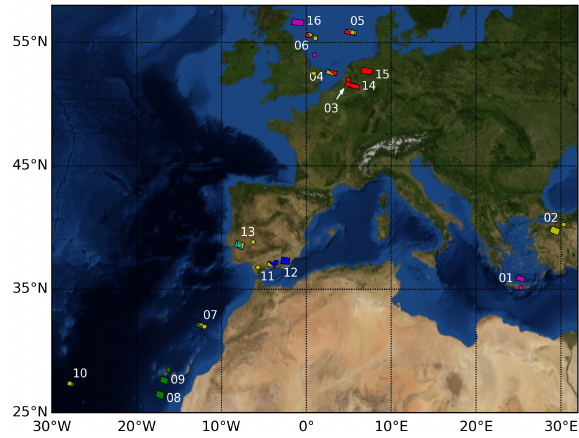
Figure 5. Overview of GOME-2A target pixels (numbered quad- rangles) and corresponding lidar measurements (circles). The li- dar measurements are described in Table 5. Color code for li- dar measurements: FAAM aircraft (magenta), CALIPSO (yel- low), Cabauw (red), Santa Cruz (green), Granada (blue), and Evora (cyan). For some pixels, two lidar measurements are avail- able for evaluation. There are nine GOME-2A target pixels over sea (target pixels 01, 04, 05, 06, 07, 08, 09, 10, 16) and seven over land (target pixels 02, 03, 11, 12, 13, 14, 15). The aerosol scenes are described in Table